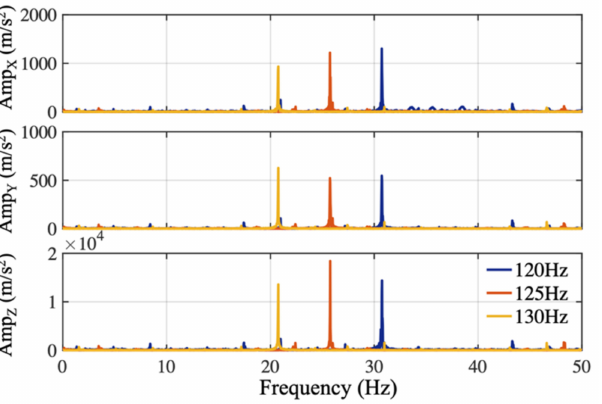
Figure 2. Aliasing frequency signals resulting from sampling 120, 125, and 130 Hz audio waves at 100